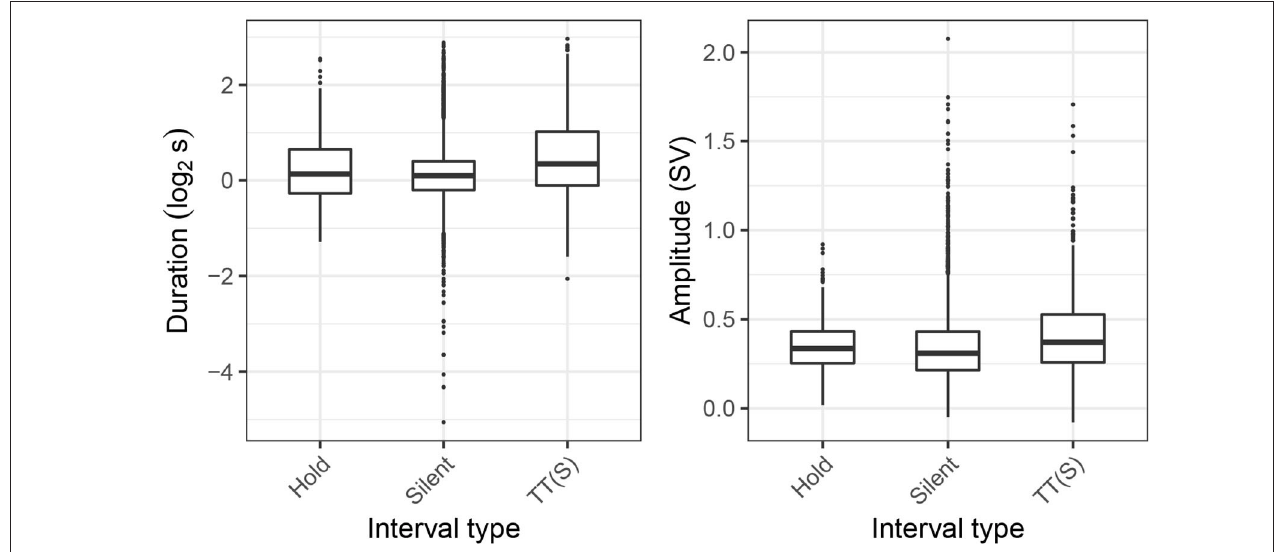
FIGURE 10 | Distribution of inhalation duration and amplitude in silent cycles (Silent), silent cycles coinciding with respiratory holds (Hold), and pre-speech inhalations in TT(S) intervals.